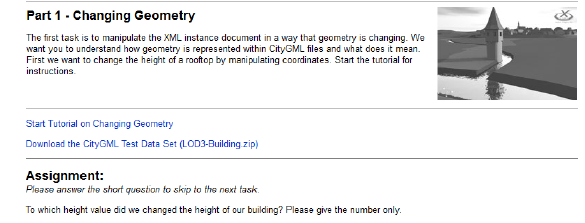
Figure 6: Subtask- Changing geometry